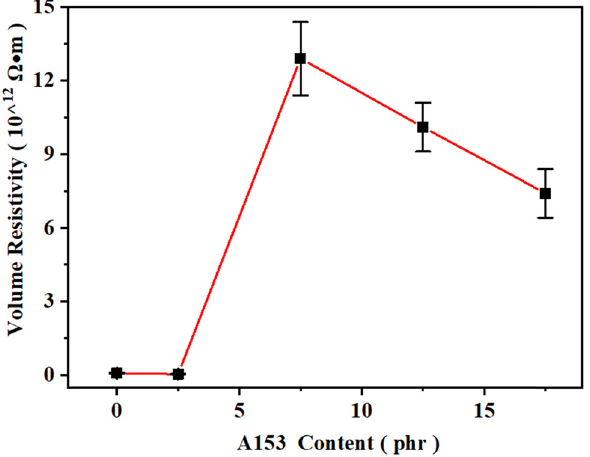
Figure 4: E ff ect of A153 content on volume resistivity of PP